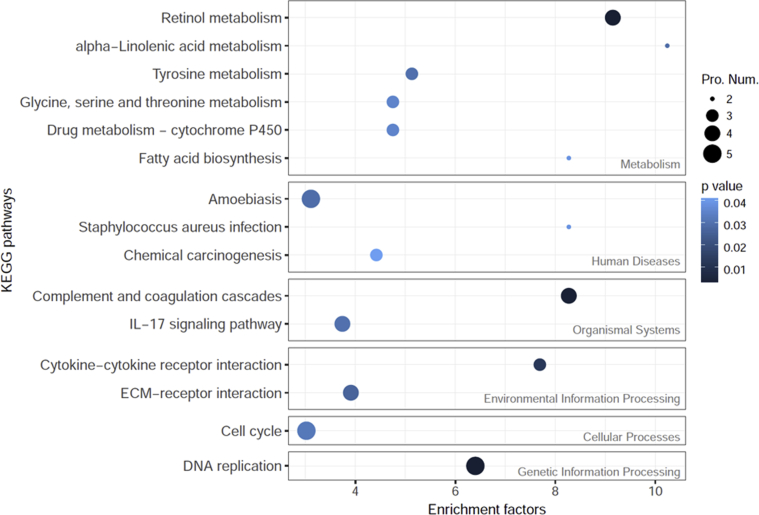
Enriched KEGG pathways of up/down regulated proteins in well-differentiated normal human primary bronchial/tracheal epithelial cells compared with un-differentiated cells. The grey labels identify the highest-order KEGG pathway classification entries. The size of the dot indicates the number of proteins in the up/down protein set. P values were obtained by Fisher's test.